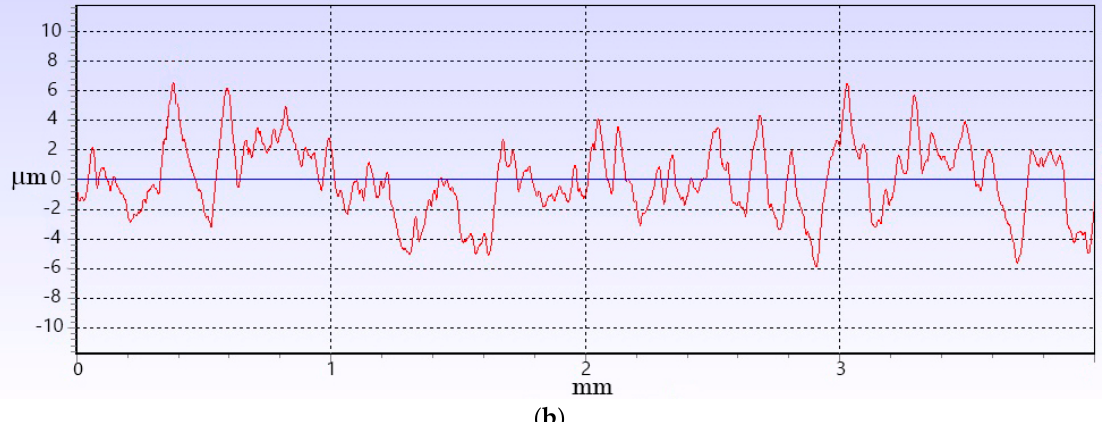
Figure 3. The profile curves of the samples surfaces obtained after machining by rotational turning with the roughness about 80 µm ( a ) and 10 µm ( b ): 1 - single placed; 2 - ridge-shaped protrusions.